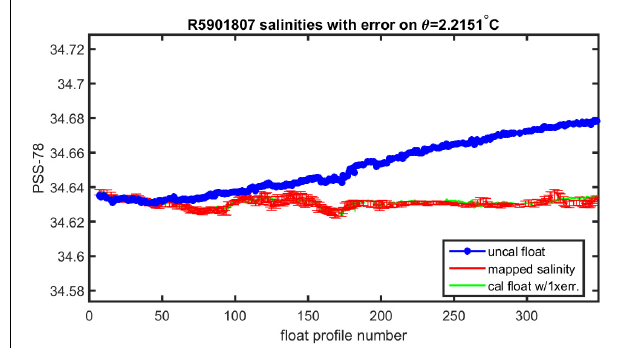
FIGURE 3 | Salinity on a deep potential isotherm plotted vs. profile number for Argo Float WMO ID 5901807 showing the uncalibrated float data (blue line), which drift salty, the climatological values mapped from GO-SHIP and other data (red lines with error bars), which are relatively constant, and the calibrated float data (green line), which has been adjusted to the climatology using a piecewise linear fit following Owens and Wong (2009). Profiles are taken every 10